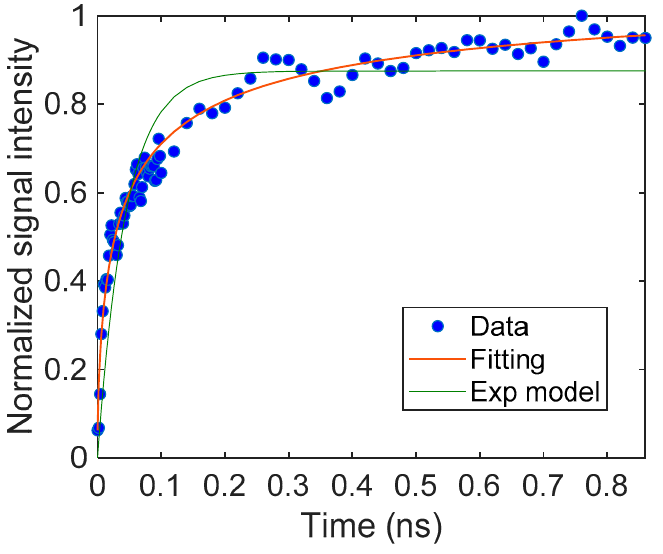
Figure 3. The rising part of the TiO 2 particulate film and the fitting curve obtained from Equation (4). The parameters were S = 18.2 (–), β = 6.16 ( μ m − 1 ), and D N = 0.594 ( μ m 2 / μ s). For comparison, a fitting curve using an exponential model is also shown.